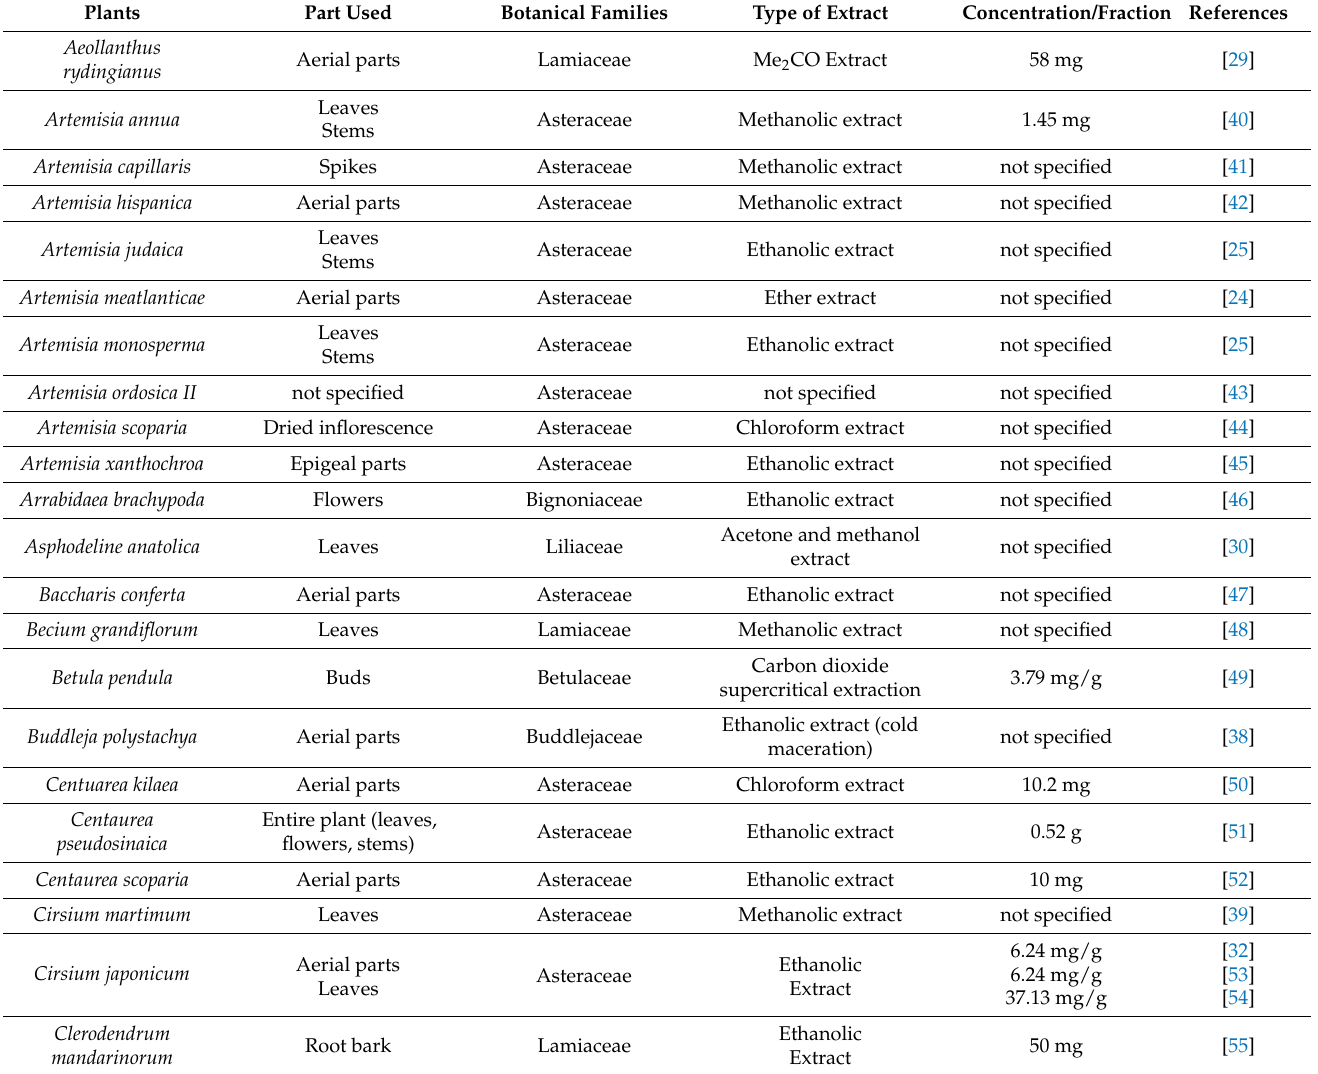
Table 1. Plant sources of